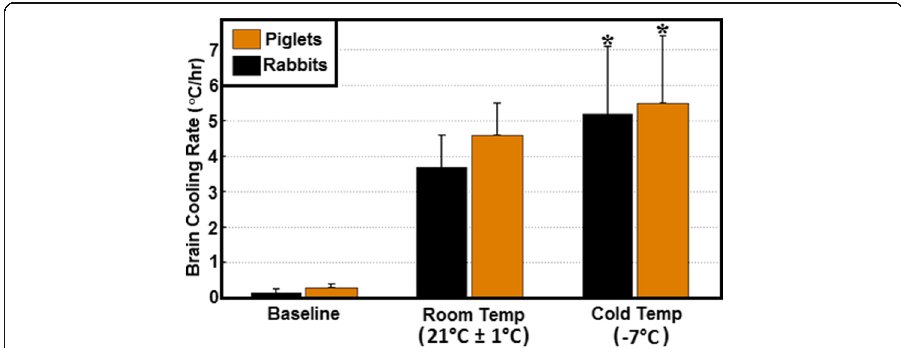
Fig. 4 Mean brain cooling rate with different nasopharyngeal cooling methods on rabbits and piglets. Asterisk signifies a statistically significant ( p < 0.05) difference between cold temperature versus room temperature in the same